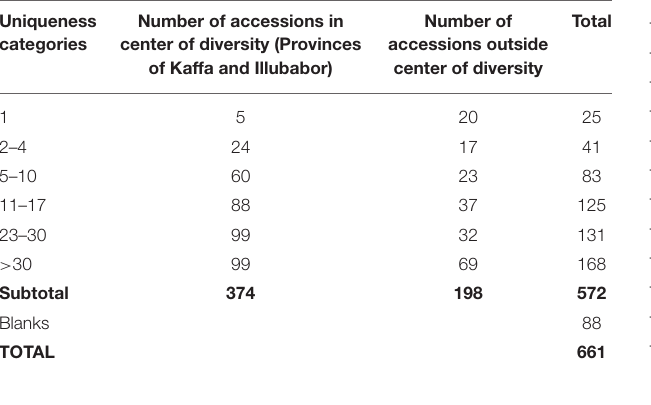
TABLE 6 | Number of accessions within and outside center of diversity.